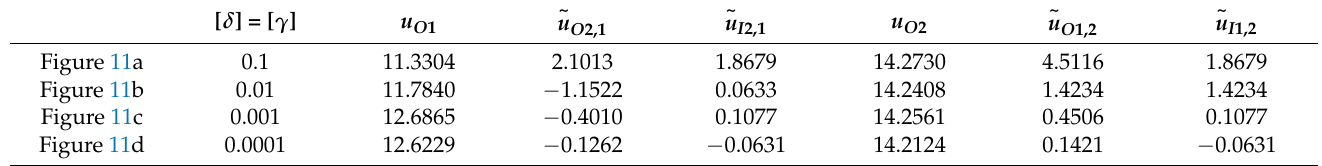
Table 4. Output and input coupling indices of the four design results shown in Figure